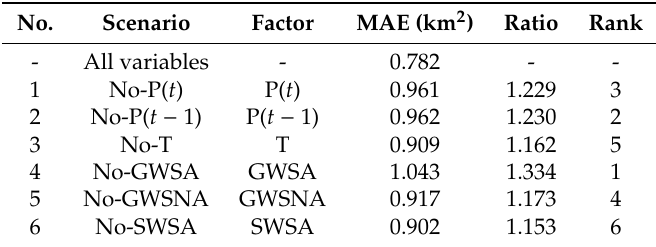
Figure 10. Box plot of absolute relative bias distributions of simulation with different input variables sets; The ends of boxes represent the first and third quartiles, and the whiskers represent the values at 1.5 standard deviations. Table 7. Sensitivity analysis results of impact factors for six-monthly SIA.